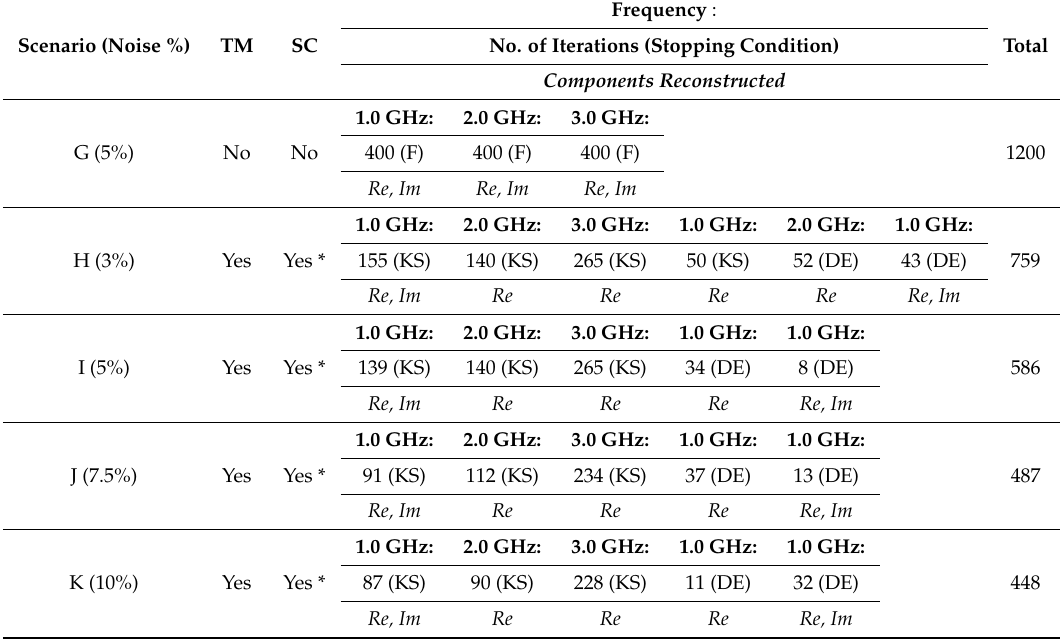
Table 3. Reconstruction progression of Category D model noise-variant scenarios (Figure